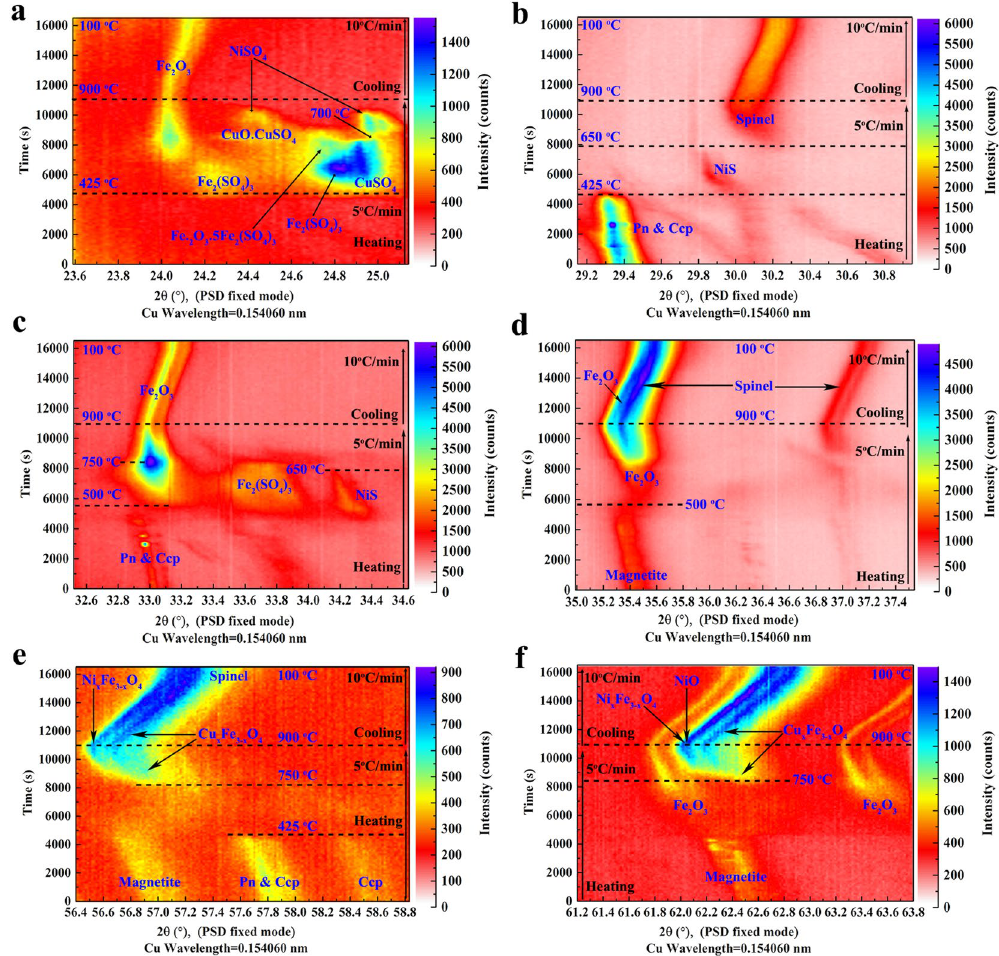
Figure 4. Series of characteristic peaks (2 θ angle approximately 21°, 28°, 32°, 35°, 56°, and 61° for ( a – f respectively) obtained with a small angle range (~2° in 2 θ ) using in–situ laboratory–based XRD with the PSD fixed model during the oxidative–roasting